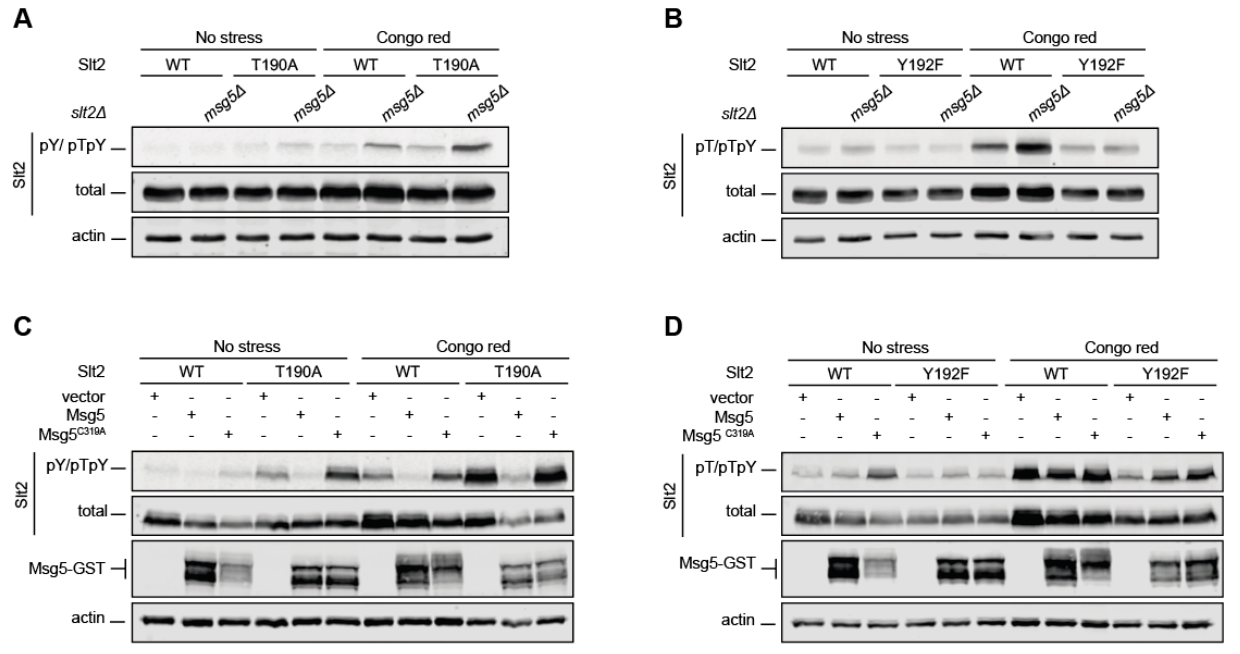
Figure 4. Analysis of the dephosphorylation and trapping of differentially phosphorylatable forms of Slt2 by Msg5. ( A , B ) msg5 Δ slt2 Δ (YGGR34 strain) cells containing the plasmid pRS316 expressing, as indicated, Slt2 (WT), Slt2 T190A , or Slt2 Y192F , were grown to the mid-exponential phase in YPD and then stimulated with 30 µg/mL of CR for 2 h. Cell extracts were resolved by SDS–PAGE, and analyzed by immunoblotting with anti-Slt2-pY/pTpY and anti-Slt2-pT/pTpY, as in Figure 1; anti-Mpk1 (total); and anti-actin antibodies. ( C , D ) Yeast extracts from slt2 Δ (Y0093 strain) cells co-transformed with the plasmid pRS315 bearing the same Slt2 versions as in ( A , B ), and with YEp352 expressing Msg5 or Msg5 C319A fused to Glutathione S-transferase (GST), were resolved by SDS–PAGE and analyzed by immunoblotting with the same antibodies as in ( A , B ), as well as with an anti-GST antibody. A representative assay from three different experiments with distinct transformants is shown.